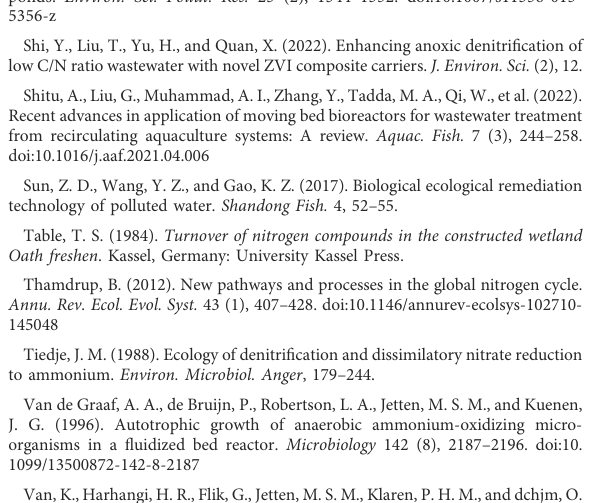
Table, T. S. (1984). Turnover of nitrogen compounds in the constructed wetland Oath freshen . Kassel, Germany: University Kassel